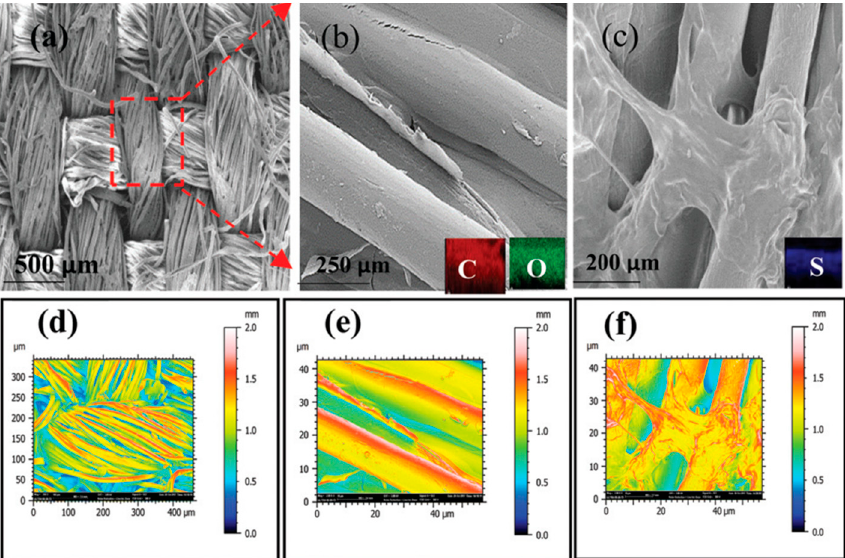
Figure 2. Reduced graphene oxide poly(3,4-ethylenedioxythiophene): poly (styrenesulfonate) (rGO-PEDOT:PSS) film-coated fabric of the flexible and washable thermoelectric nanogenerator fabricated by Khoso et al. [78]. This nanogenerator has potential application for harvesting green energy from human body heat. FESEM images with magnifications of ( a ) 500 µ m and ( b ) 250 µ m rGO-coated fabric and ( c ) 200 µ m of rGO-PEDPT:PSS coated fabric. ( d – f ) Color mapping of SEM images’ infrared rendering. Reprinted with permission from [78]. Copyright 2021, Royal Society of Chemistry.